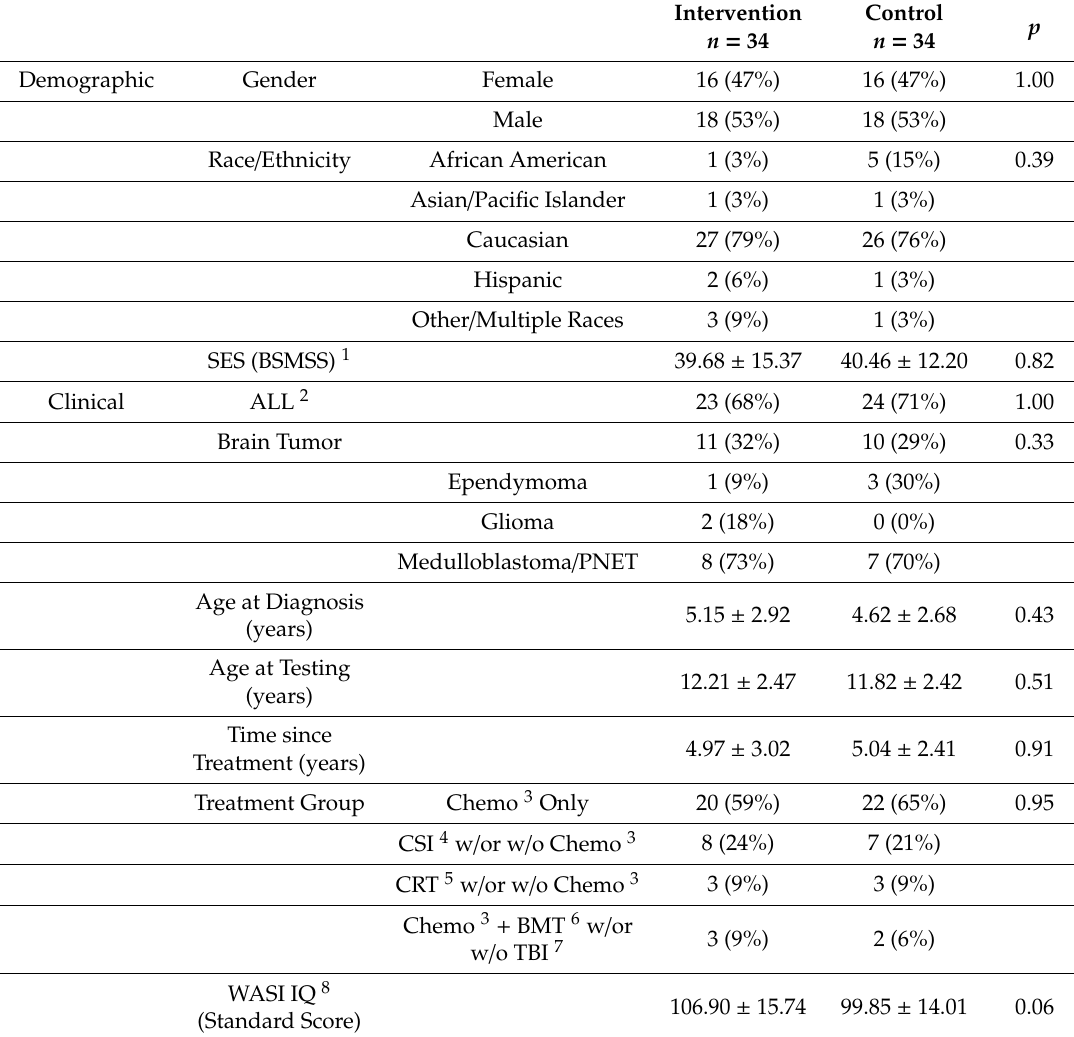
Table 1. Participant